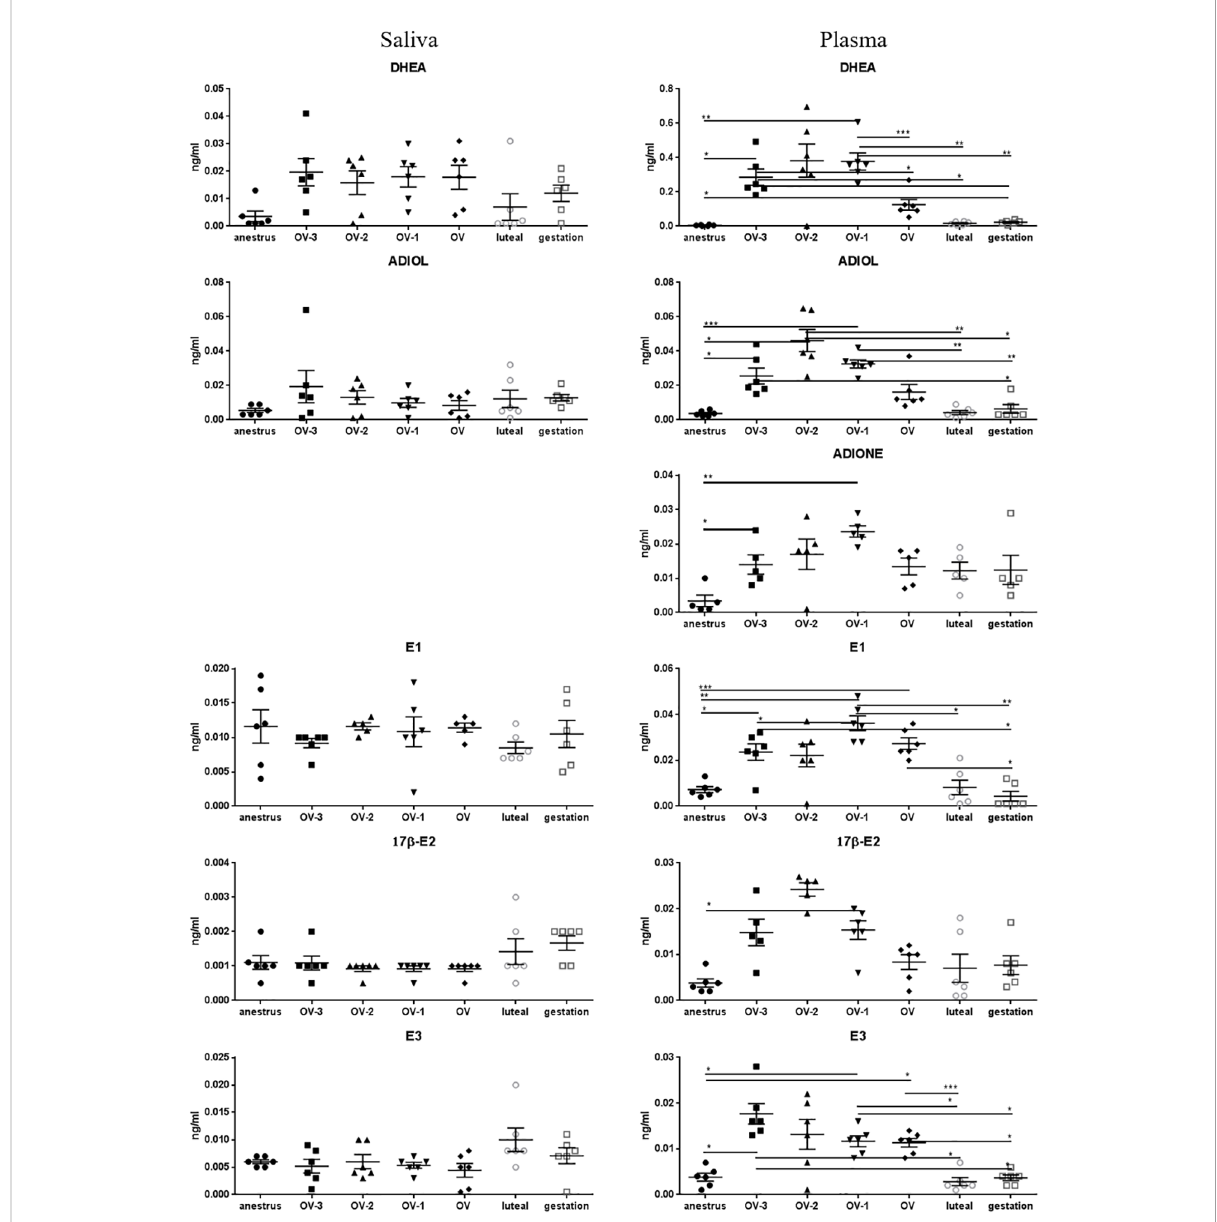
FIGURE 6 Gas chromatography coupled to tandem mass spectrometry (GC-MS/MS) measurements of the concentrations of dehydroepiandrosterone (DHEA), androstenediol (ADIOL), androstenedione (ADIONE), estrone (E1), 17 b -estradiol (17 b -E2) and estriol (E3) (ng/mL ± SEM) in mare saliva and plasma collected during anestrus, during follicular phase 3 days (OV-3), 2 days (OV-2) and 1 day (OV-1) before ovulation, the day when ovulation was detected (OV), during luteal phase 6 days post-ovulation (luteal), during gestation 18 days post-ovulation (gestation). For each steroid, the y-axis was standardized to the maximal concentration, so that the variations are easy-to-read. Statistical differences between physiological stages: * P < 0.05, ** P < 0.01, *** P <